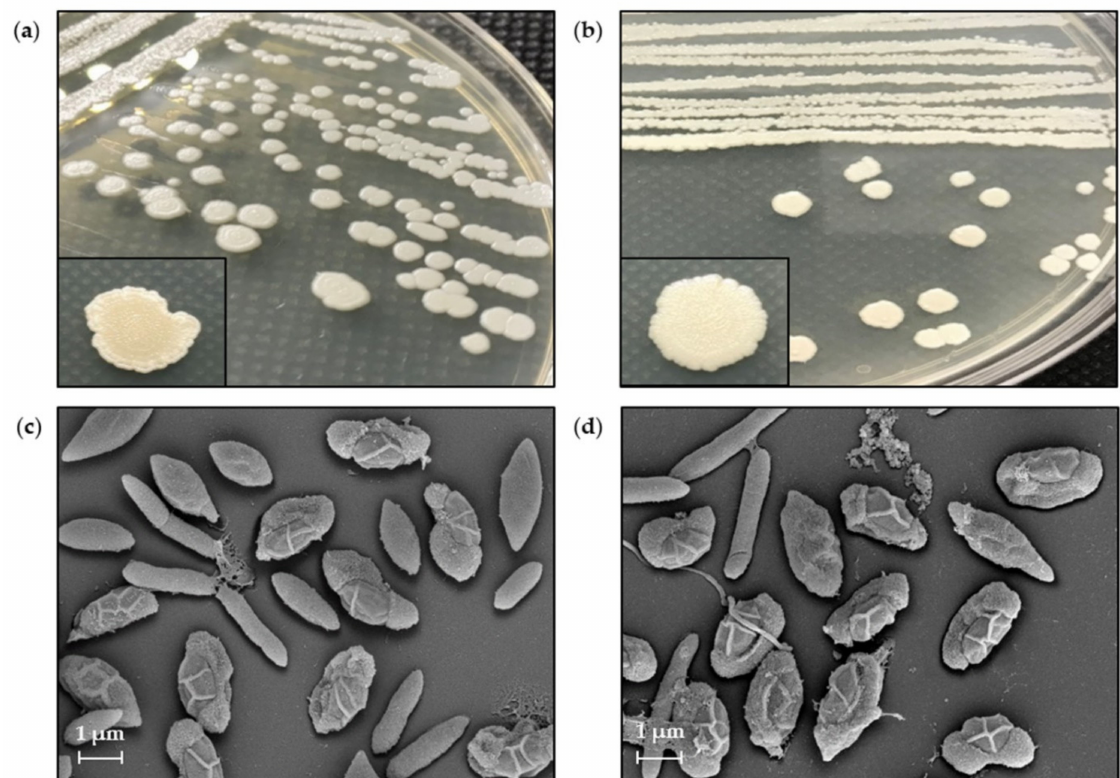
Figure 6. Colony morphology of Brevibacillus sp. SPR19 of ( a ) wild-type and ( b ) M285 strains. The SEM micrograph of vegetative cells and spores of ( c ) wild-type and ( d ) M285 strains at magnitude 10,000 × . The vegetative cells and spores were obtained by cell incubation on MH agar at 30 ◦ C for 8